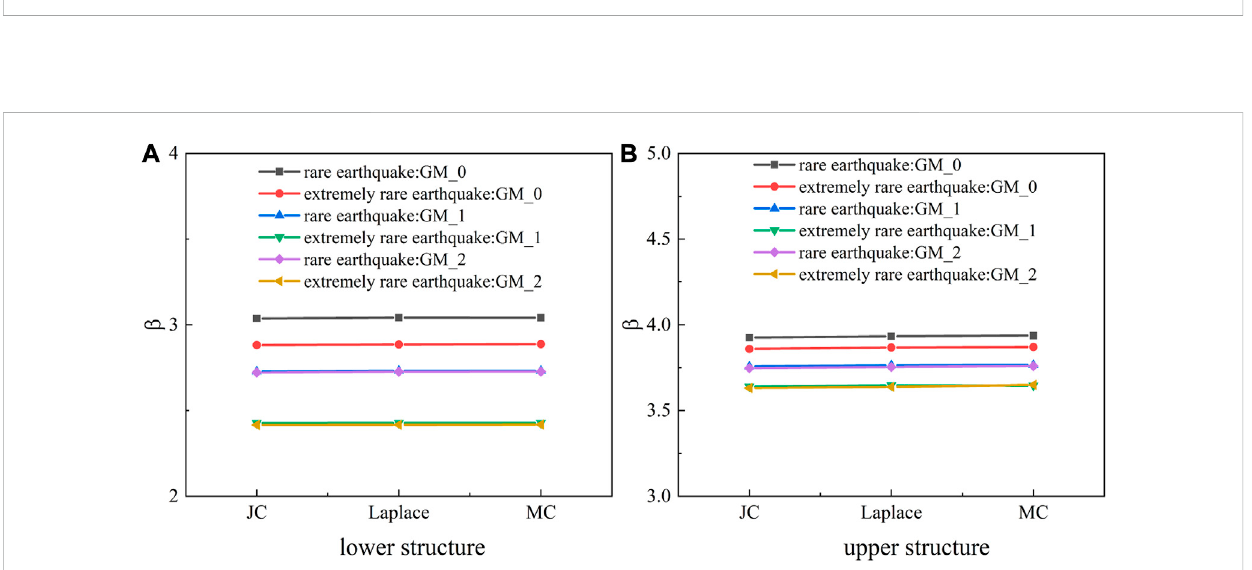
FIGURE 7 Comparison of failure probability of different